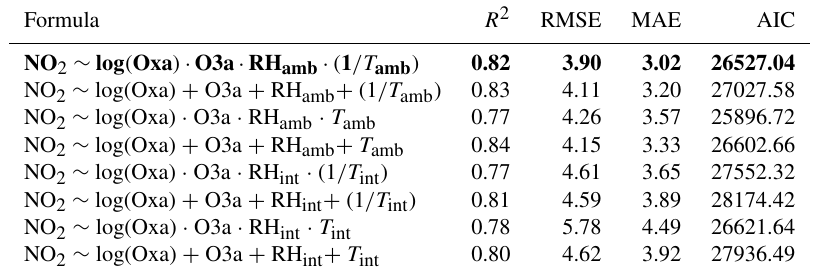
Table 2. Results of the MLR model selection process for NO 2 . The most accurate model is in bold. RMSE and MAE are in units of parts per billion.